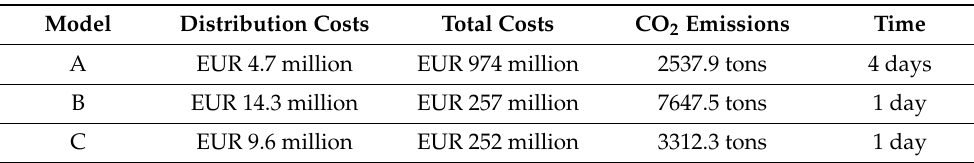
Table 8. Final assessment of the three NH 3 distribution models.